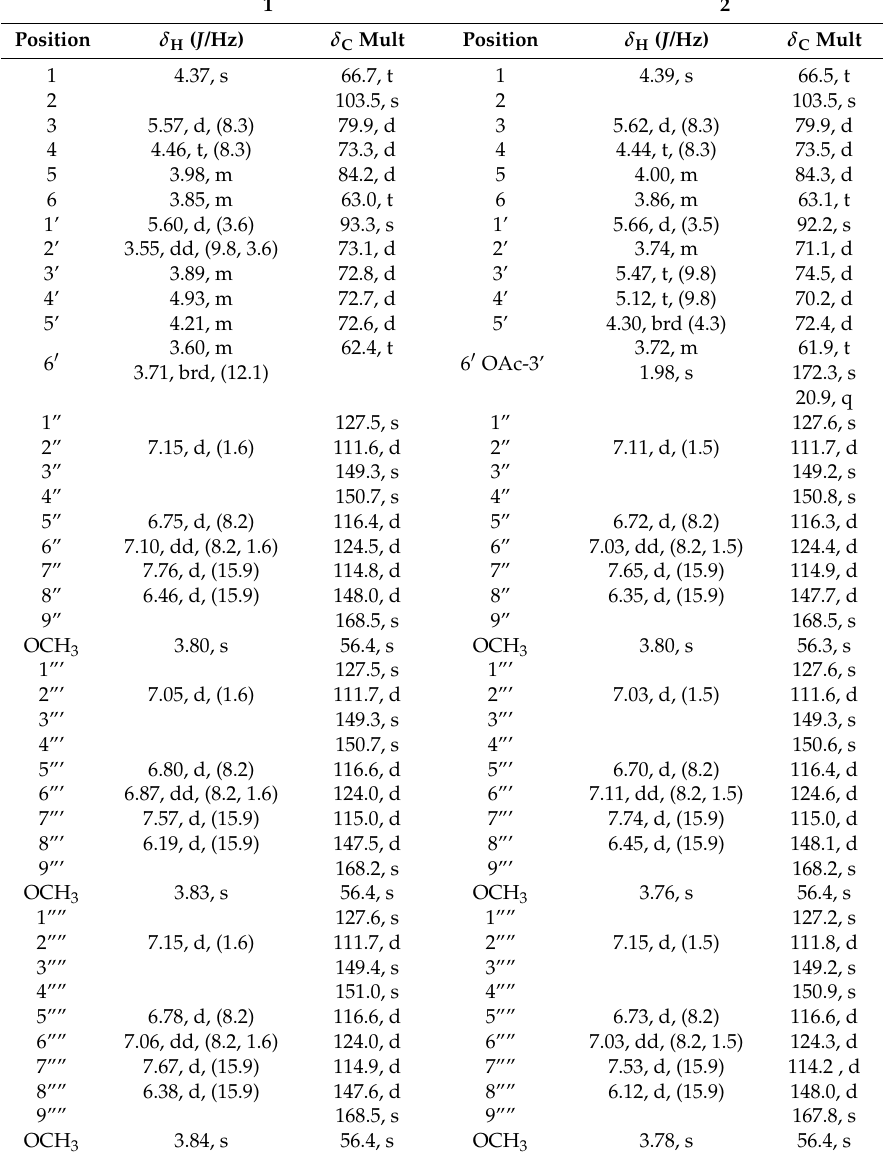
Table 1. 1 H- (400 MHz) and 13 C-NMR (150 MHz) data of 1 and 2 in CD 3 OD ( δ in ppm, J in Hz). 1 2 Position δ H ( J /Hz) δ C Mult Position δ H ( J /Hz) δ C